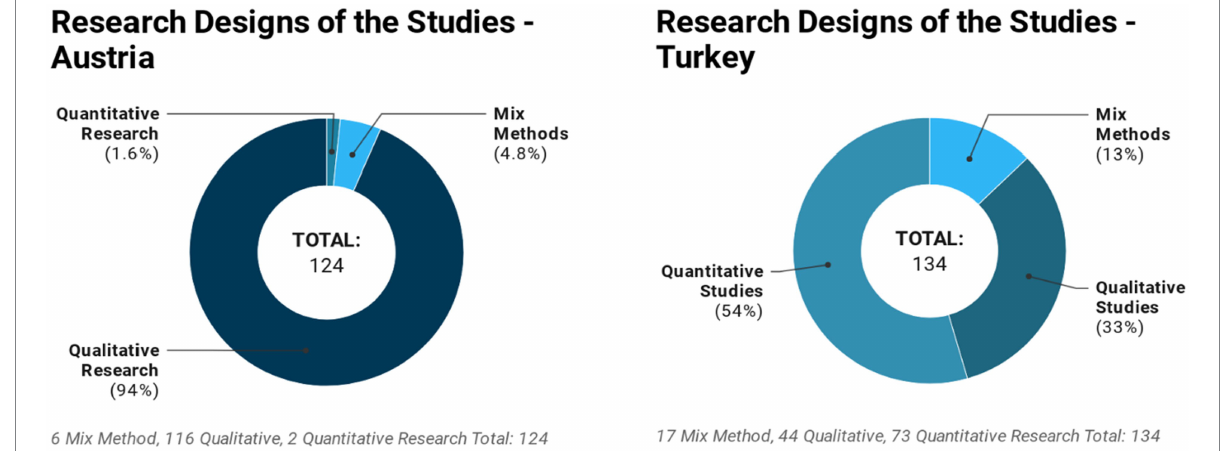
FIGURE 4 Distribution of master’s and PhD theses from Austria and Turkey by research design.